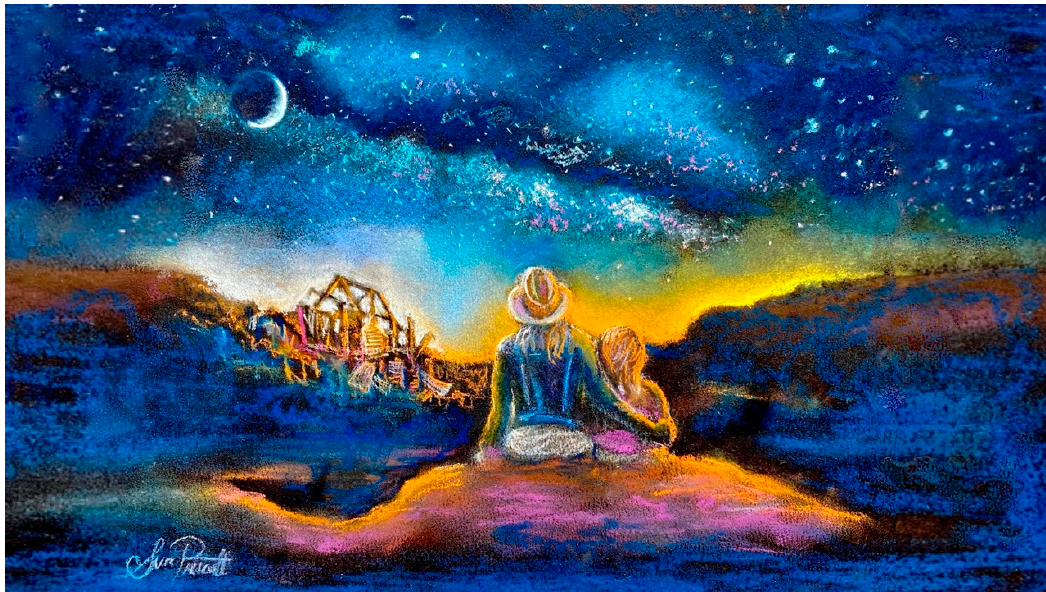
Figure 3. Traumatic events can act as catalysts that accelerate change through new awareness and new opportunities that might not have occurred (or taken longer). (Image inspired by wisdom of Japanese poet Mizuta Masahide; created by S.L.P).